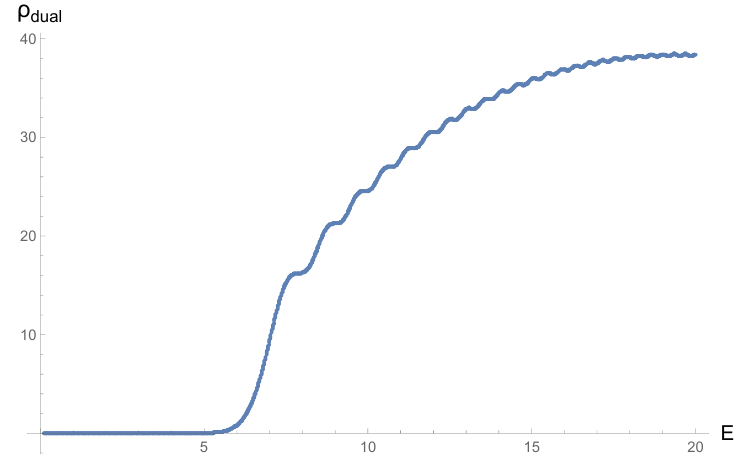
Figure 3 . The density of states for (cid:22) = 10 as a function of the energy E . It exhibits an exponential growth that is then transitioning to a Dyson semicircle law with superimposed